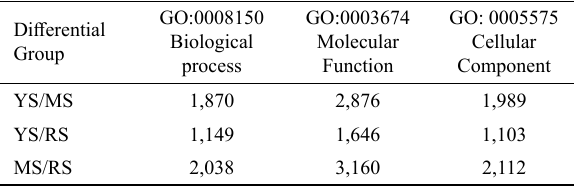
YS, young stage; MS, mature stage; RS, ripening